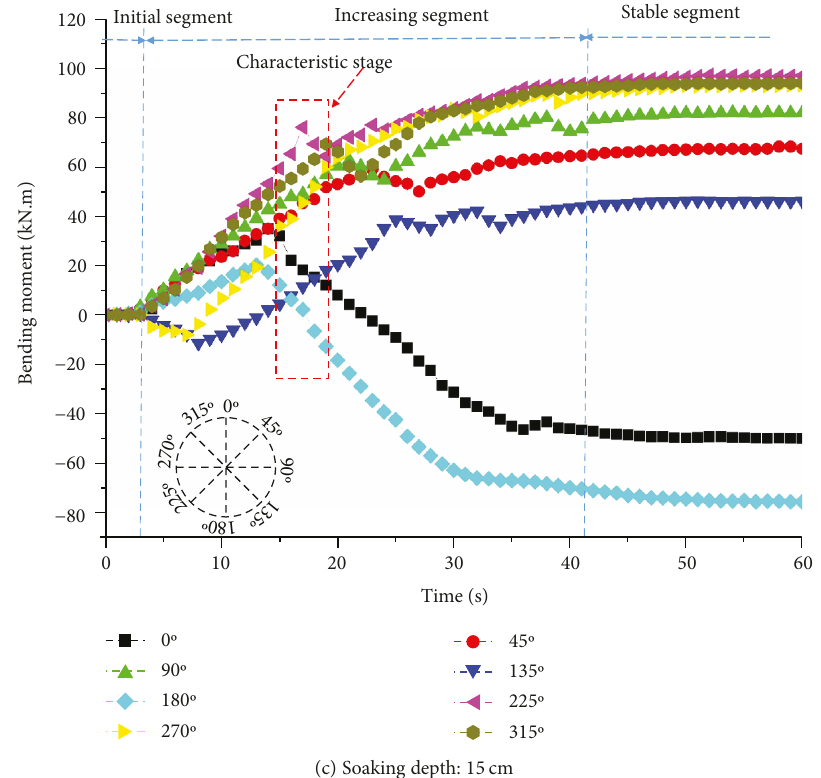
Figure 14: Bending moment of full-range soaking with operating time.